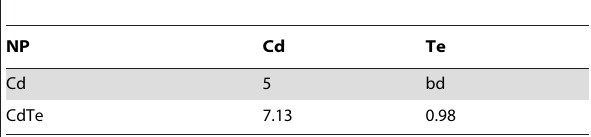
Table 2. Elemental analysis of purified nano-sized structures.